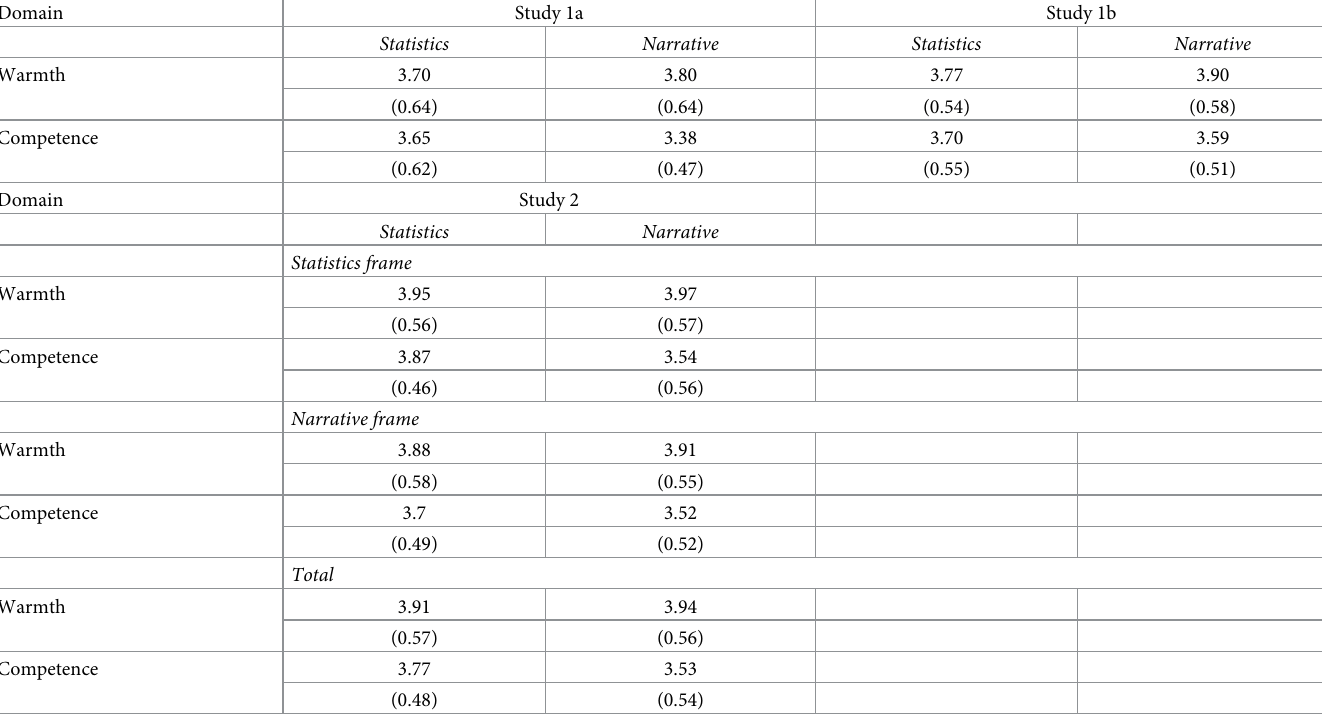
Table 3. Means of warmth and competence by evidence type and frame for studies